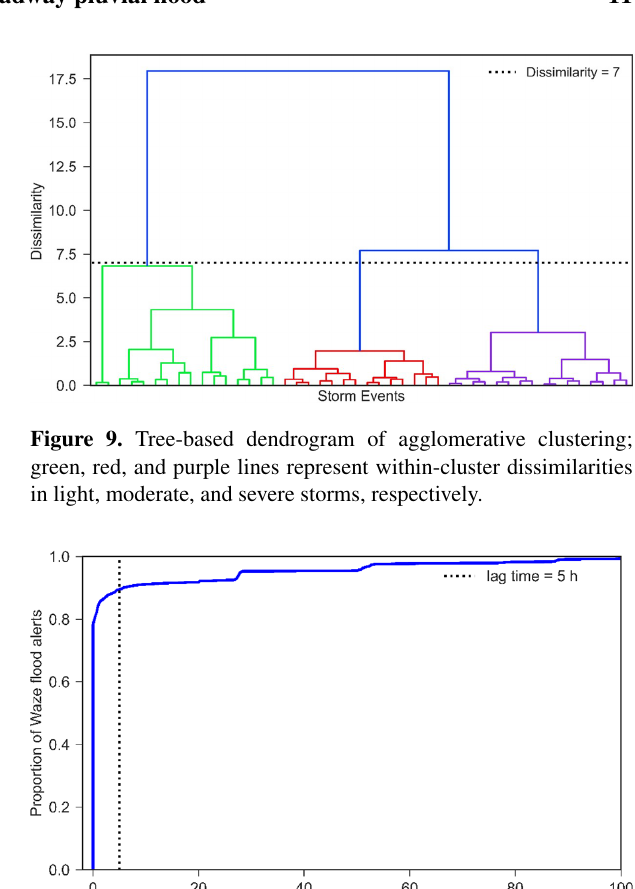
storms. The vertical axis of the dendrogram depicts the dis- similarity between storms, and the horizontal axis represents storms. The position of each split on the vertical axis shows the dissimilarity of the two clusters on sides of the split. Ta- ble 3 shows summary statistics for the three storm clusters.